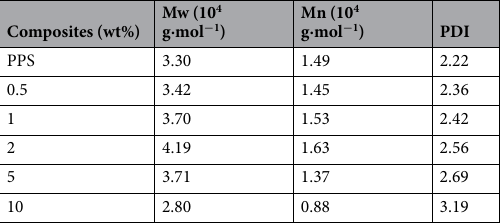
Mw (10 4 g·mol − 1 )